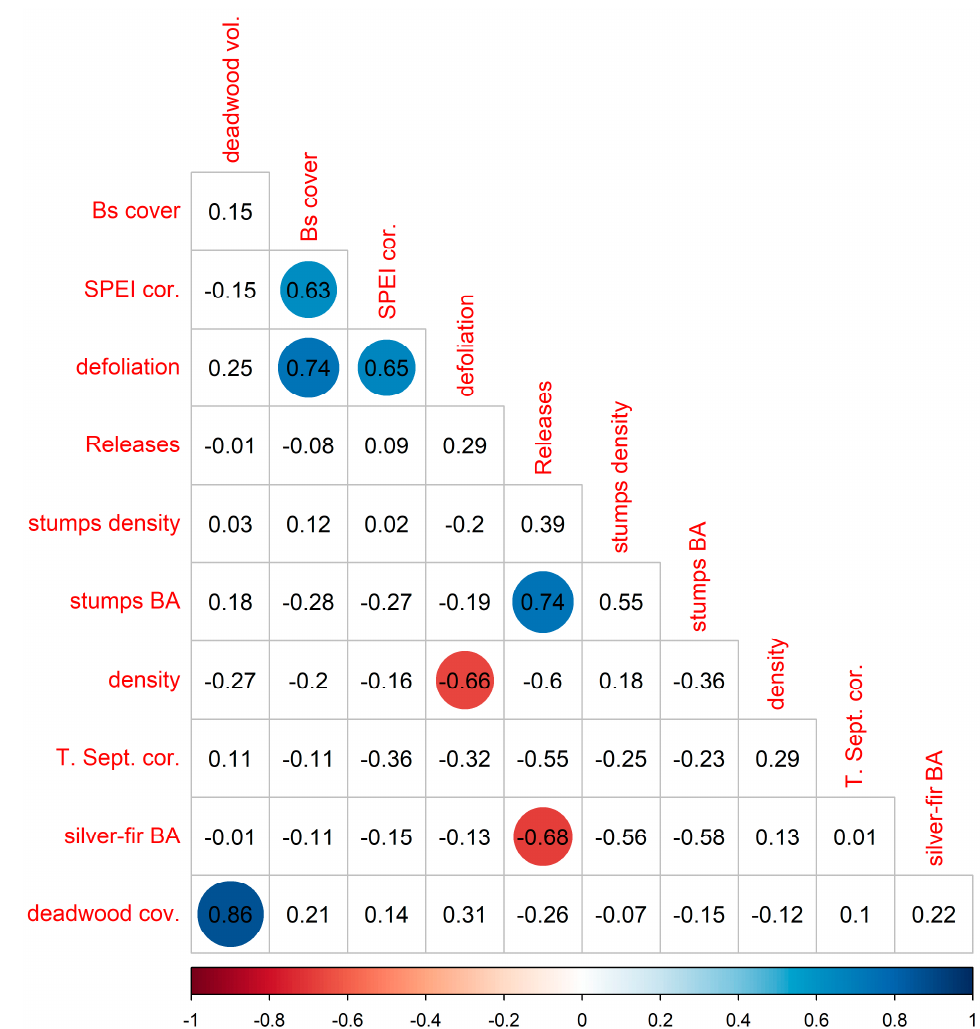
Figure 5. Correlation between the studied variables. Abbreviations are as follows: defoliation, per- centage of severely defoliated and dead trees; silver-fir BA, silver fir basal area; density, stand density; Releases, average percentage of releases; stumps BA, stumps basal area; T. Sept. cor., correlation be- tween growth and previous September maximum temperature; SPEI cor, correlation between growth and 3-month July SPEI; deadwood vol., deadwood volume; deadwood cov., deadwood cover; and Bs cover, cover of B. sempervirens in the understory. The color scale indicates the value of Spearman correlation coefficients with circle values corresponding to significant correlations ( p < 0.05).